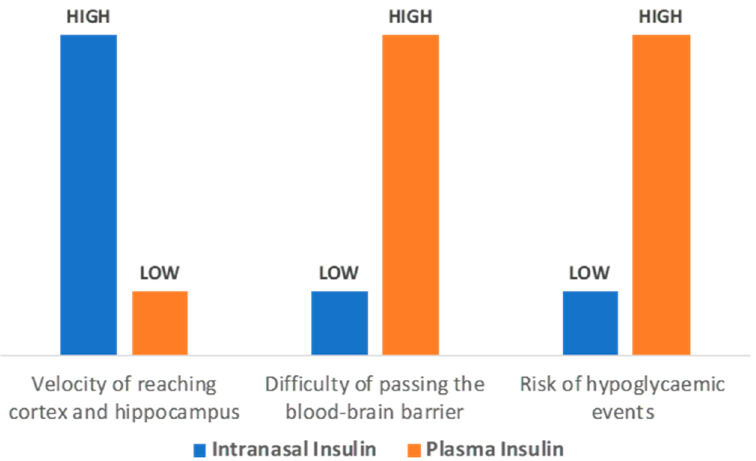
Figure 3. Intranasal insulin administration benefits for testing the cognitive improvement on AD and MCI patients.